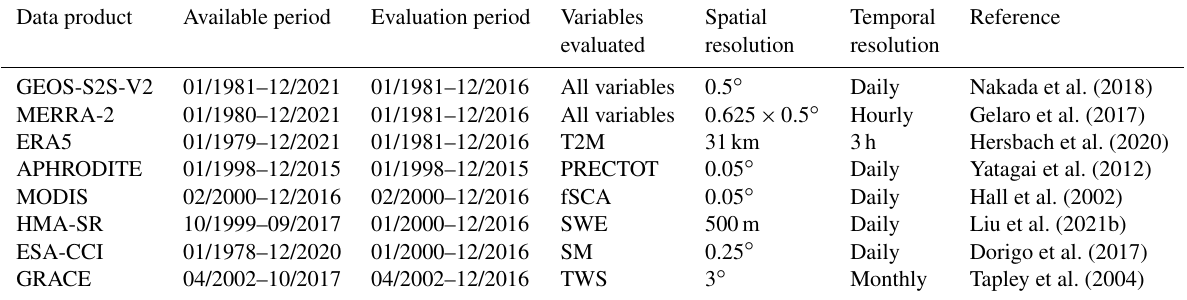
Table 1. The list of all data products used, including the GEOS-S2S V2 forecasting system, the MERRA-2 reanalysis product, and the various reference data products. The information in this table includes the period of data availability, the period used in the evaluation, the variables used in this study, the original spatial and temporal resolutions, and the main reference for each dataset. GEOS-S2S-V2, MERRA- 2, and ERA5 data are provided up until the present day, and production of these datasets occurs in near-real-time, where quality-assured monthly updates are typically published within 3 months of data production. GRACE data are originally provided at 3 ◦ spatial resolution, but the version used here is posted at 1 ◦ spatial